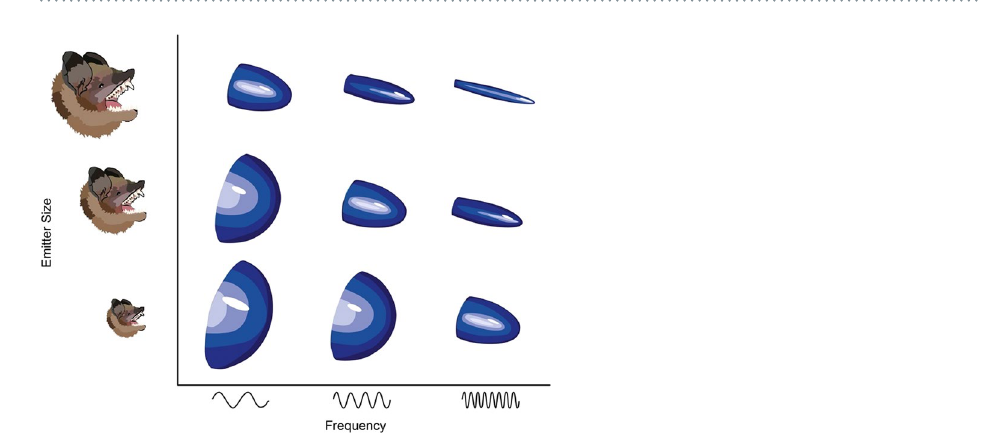
Figure 1. Body mass versus vocalization frequency for a range of vertebrates. Figure made by Sara Vukson using data presented in Jones 2 and Fletcher 43 .